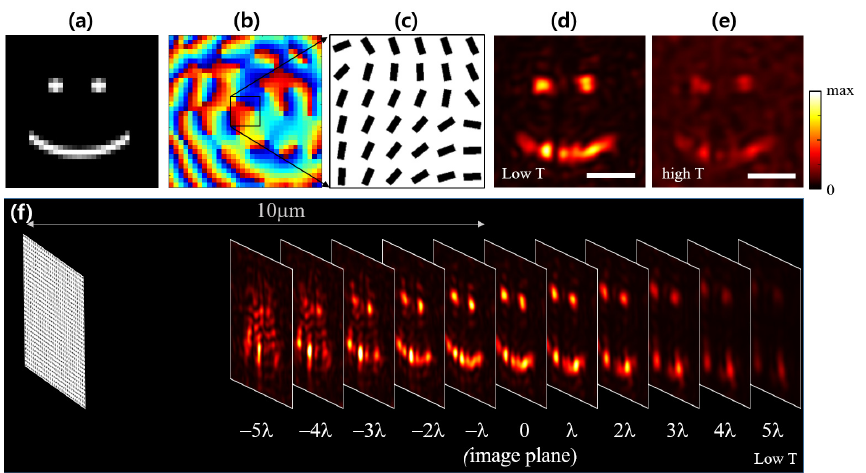
Figure 6. Switchable Fresnel hologram performed by VO 2 based reflectarray metasurface at λ = 700 nm. ( a ) Original smile image ( b ) Phase map ( c ) In-plane cut-view of Au nanorod array ( d ) Time-averaged intensity distribution at the image plane at low temperature, and ( e ) at high temperature. ( f ) Evolution of the time-averaged intensity distribution with a distance from the image plane ( z = 10 µ m). The white scale bars in ( d , e ) indicate 3 µ